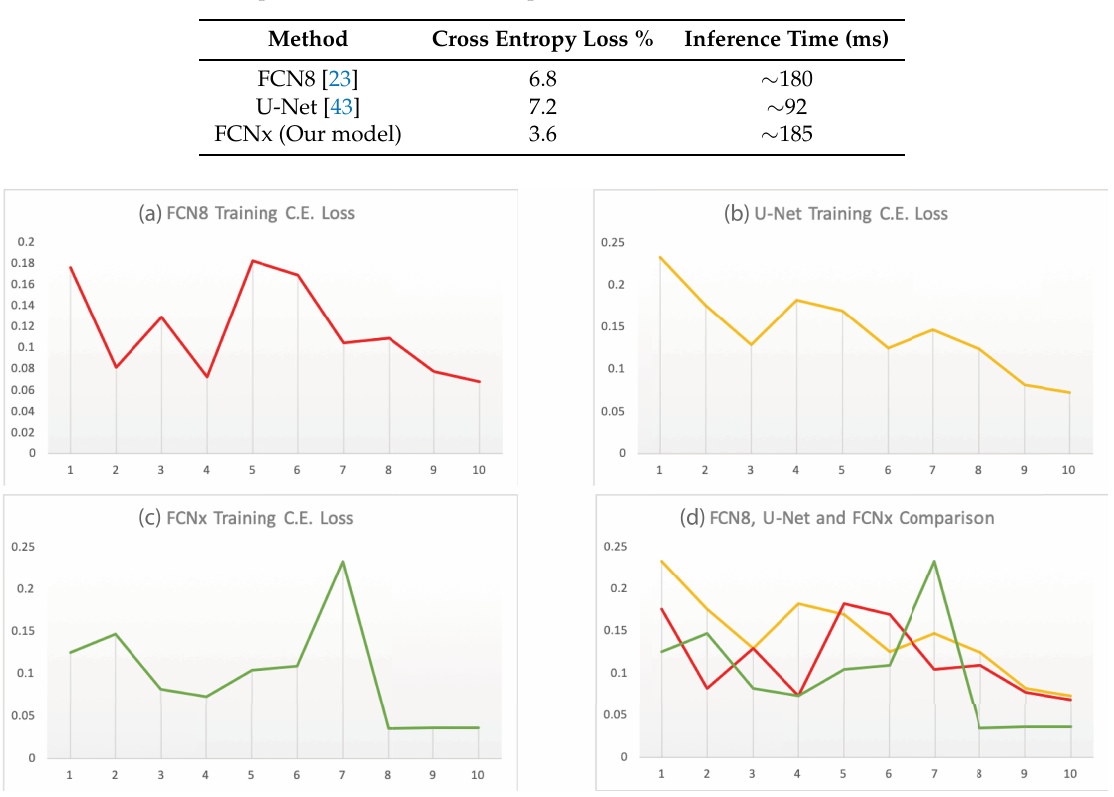
Table 2. Comparison of our architecture performance with FCN8 and U-Net networks.